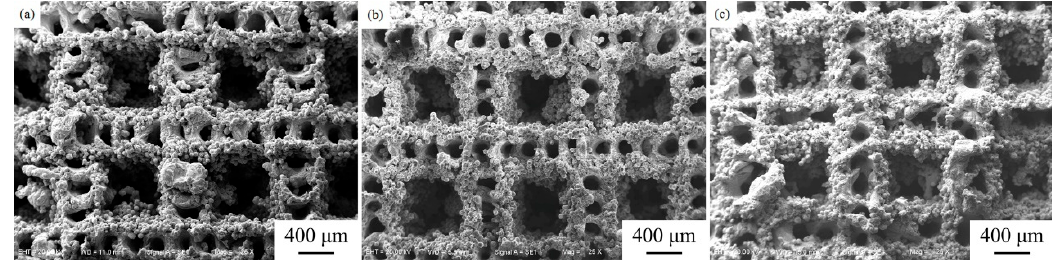
Figure 5. Cross-section morphologies of the LAMed Mg-Zn-Zr alloys. ( a ) E1, ( b ) E2, ( c ) E3.